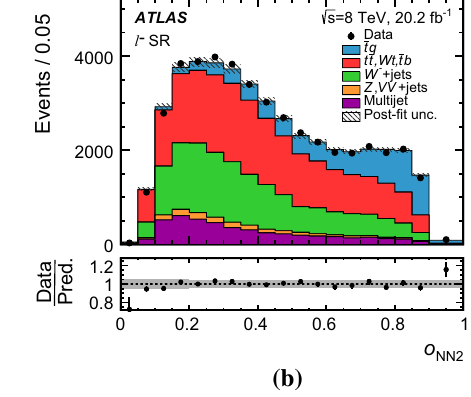
distributions are normalised to the event rates obtained by the fit to the discriminants. The hatched uncertainty band represents the total uncer- tainty in the rates of all processes after the fit and the bin-by-bin MC statistical uncertainty, added in